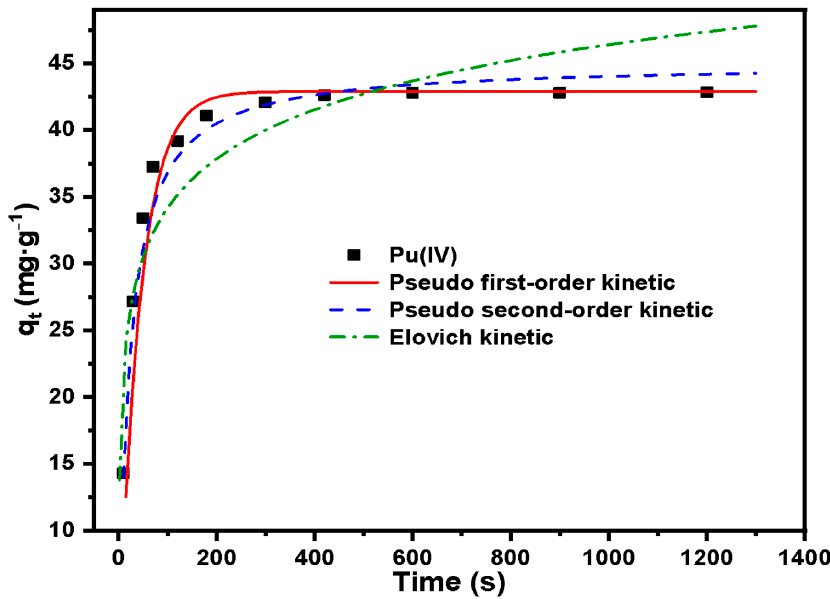
Figure 17. Adsorption kinetic model for Pu(IV) on SG-VTS-VPQ.